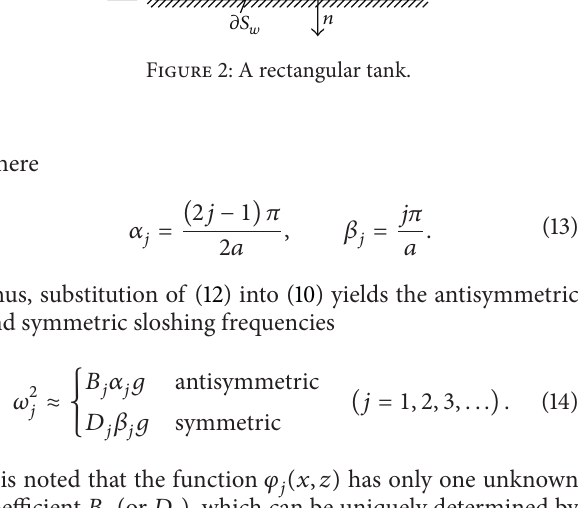
Figure 2: A rectangular tank.